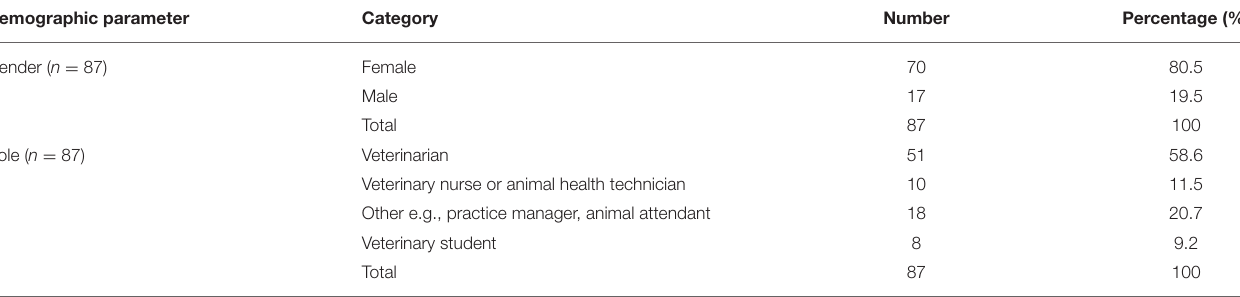
TABLE 3 | Frequency table for the demographic information on respondents to surveys both prior to and following participation in virtual ethics rounds ( n =